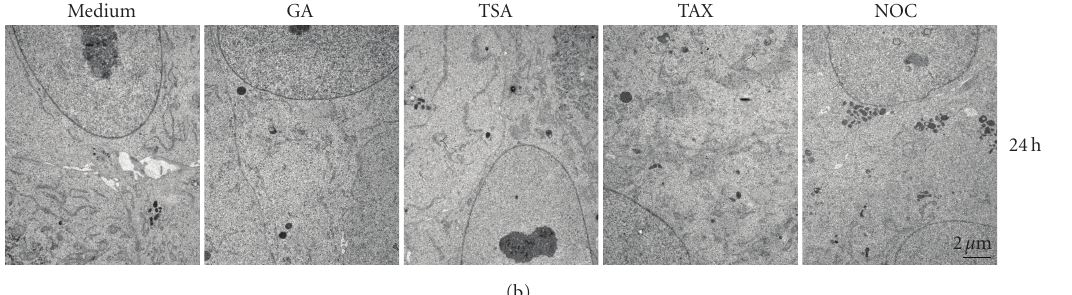
Figure 2: (a) Transmission electron micrographs of control (C) cells, and cells exposed to 5 μ M MG-132 (MG) or 0.25 μ M geldanamycin (GA) or 1 μ M trichostatin A (TSA) or 1 μ M taxol (TAX) or 5 μ M nocodazole (NOC) for 24 hours. In addition, the cells were treated simultaneously with GA or TSA or TAX or NOC and MG-132 for up to 24 hours, (b) and then allowed to recover under the indicated conditions for 24